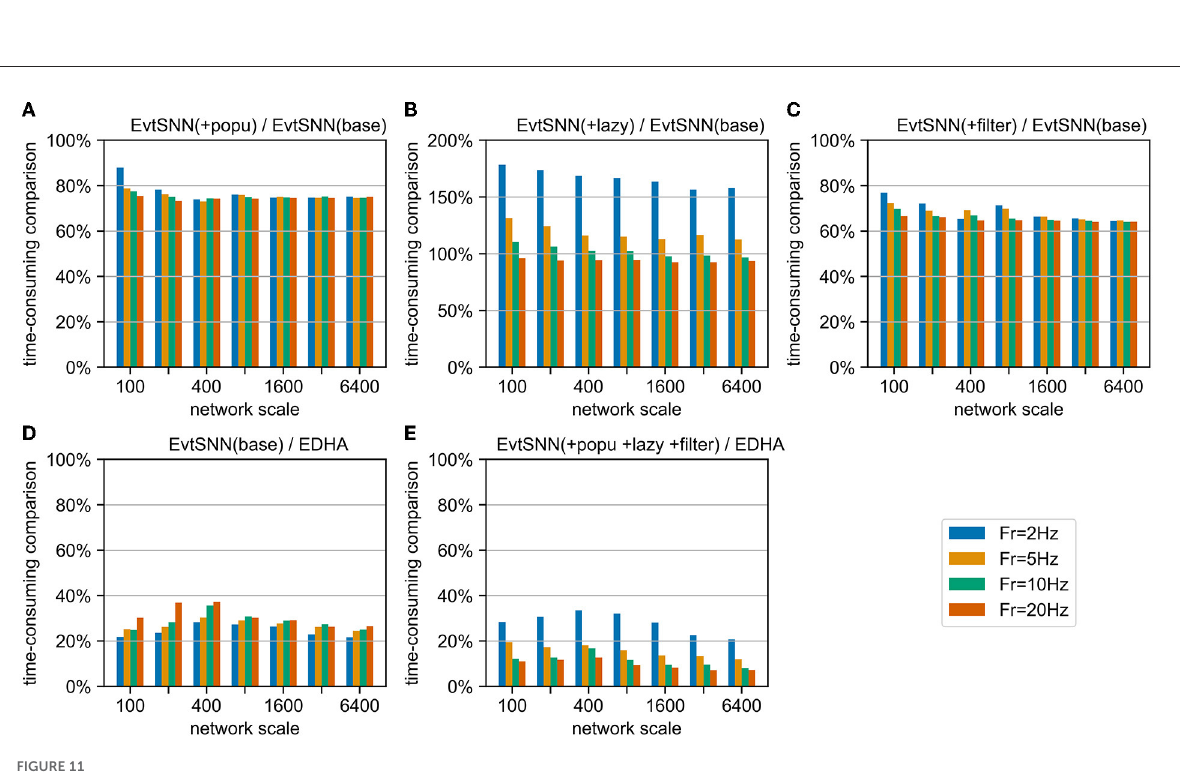
equations and the solution of spike firing time.